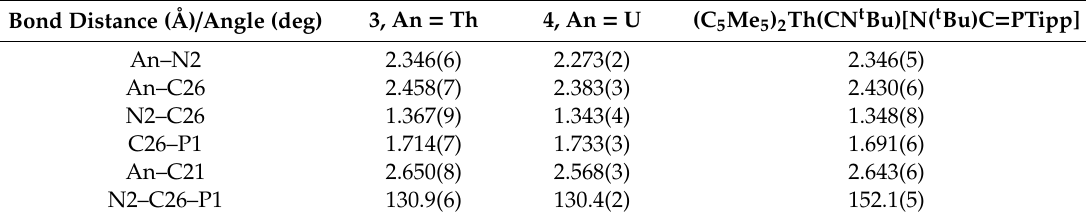
Table 1. Selected bond distances (Å) and angles in 3 and 4 with comparison to the previously